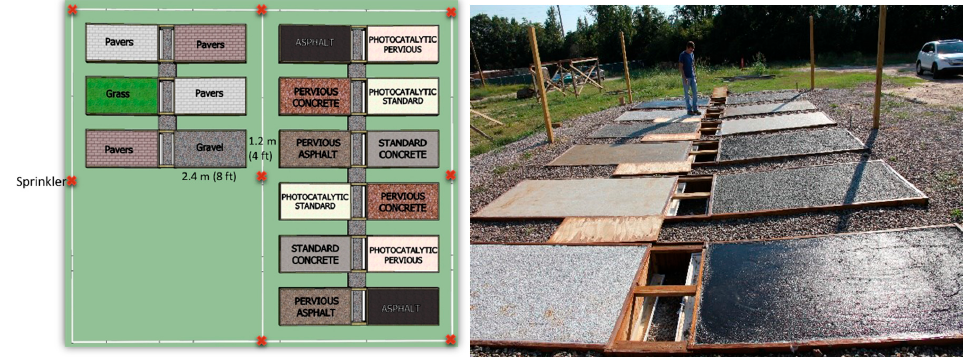
Figure 5. Field laboratory layout, Auburn University, Auburn, Alabama, 2013 [41].